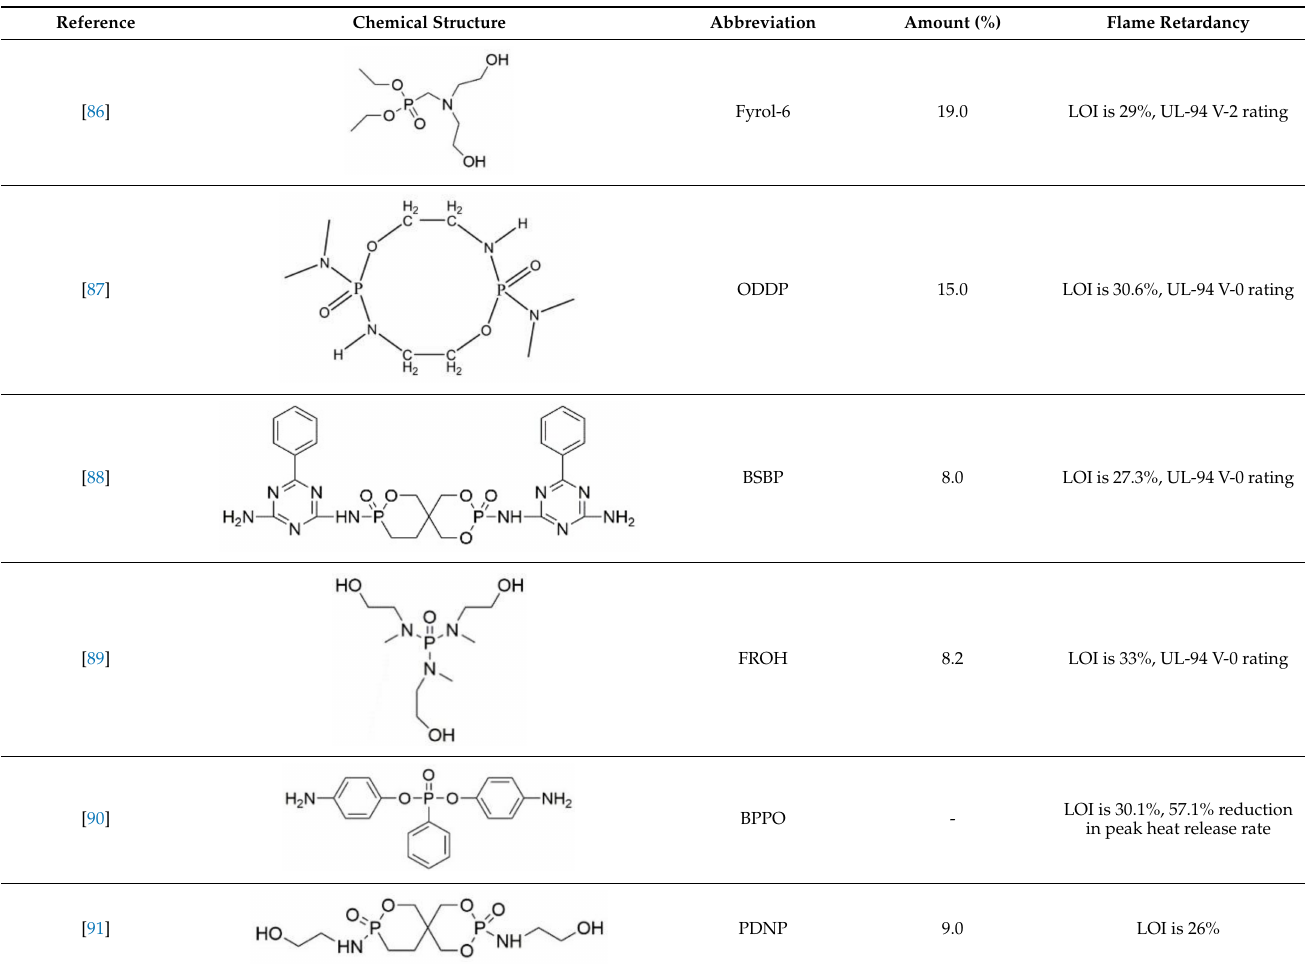
Table 3. Chemical structures of typical P–N reactive flame retardants and performance of flame-retardant